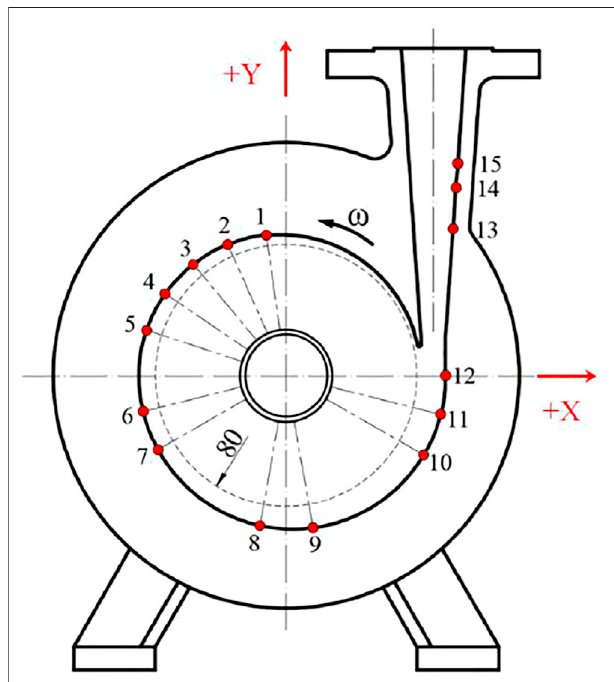
FIGURE 6 | Installation position of pressure sensor.